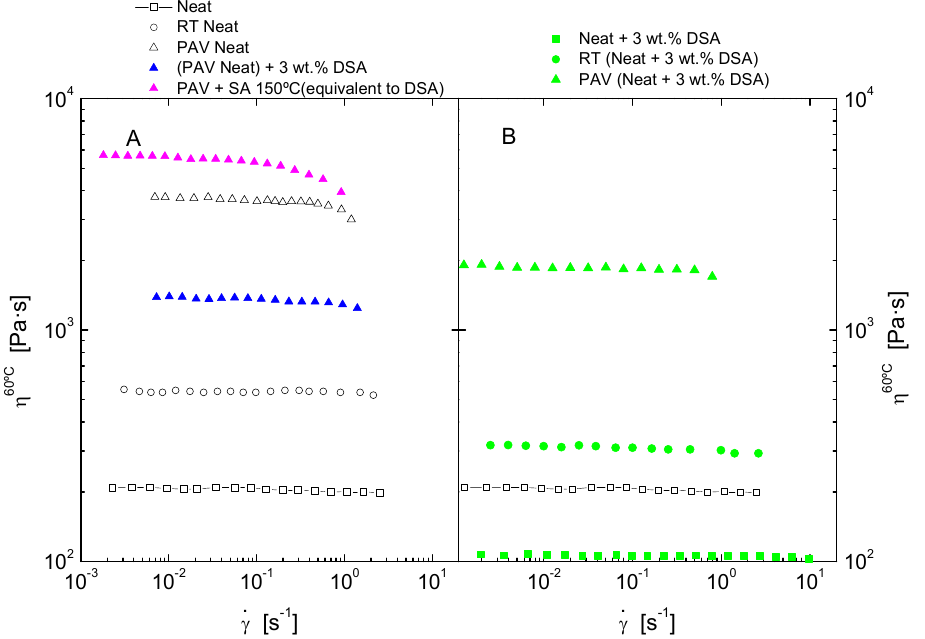
Figure 3. Viscous flow curves, at 60 ◦ C, for ( A ) neat and aged bitumen by RTFOT (RT) and PAV